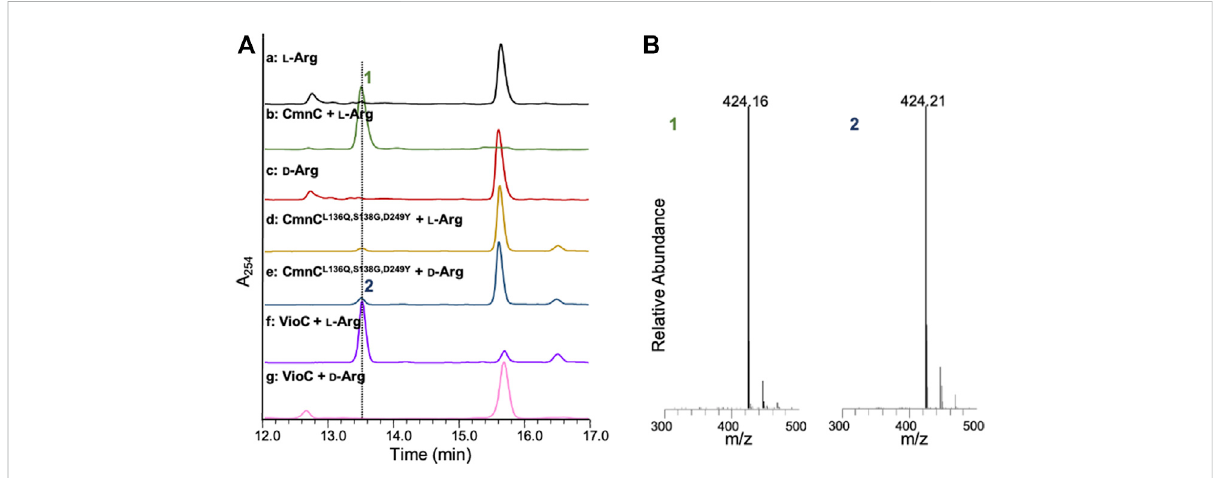
FIGURE 2 LC-MS analysis of the CmnC and VioC reactions. (A) HPLC traces of the substrate L -Arg and the enantiomer D -Arg (red) and reactions in the presenceofCmnCwith L -Arg(green),thetriplemutantCmnC L136Q,S138G,D249Y with L -Arg(yellow)or D -Arg(blue),andVioCwith L -Arg(purple)or D -Arg (pink). (B) Mass spectrometric analysis of the reaction products. Compound 1 and 2 are the reaction products of CmnC against L -Arg and CmnC L136Q,S138G,D249Y against D -Arg, respectively. All samples were dansylated before LC-MS